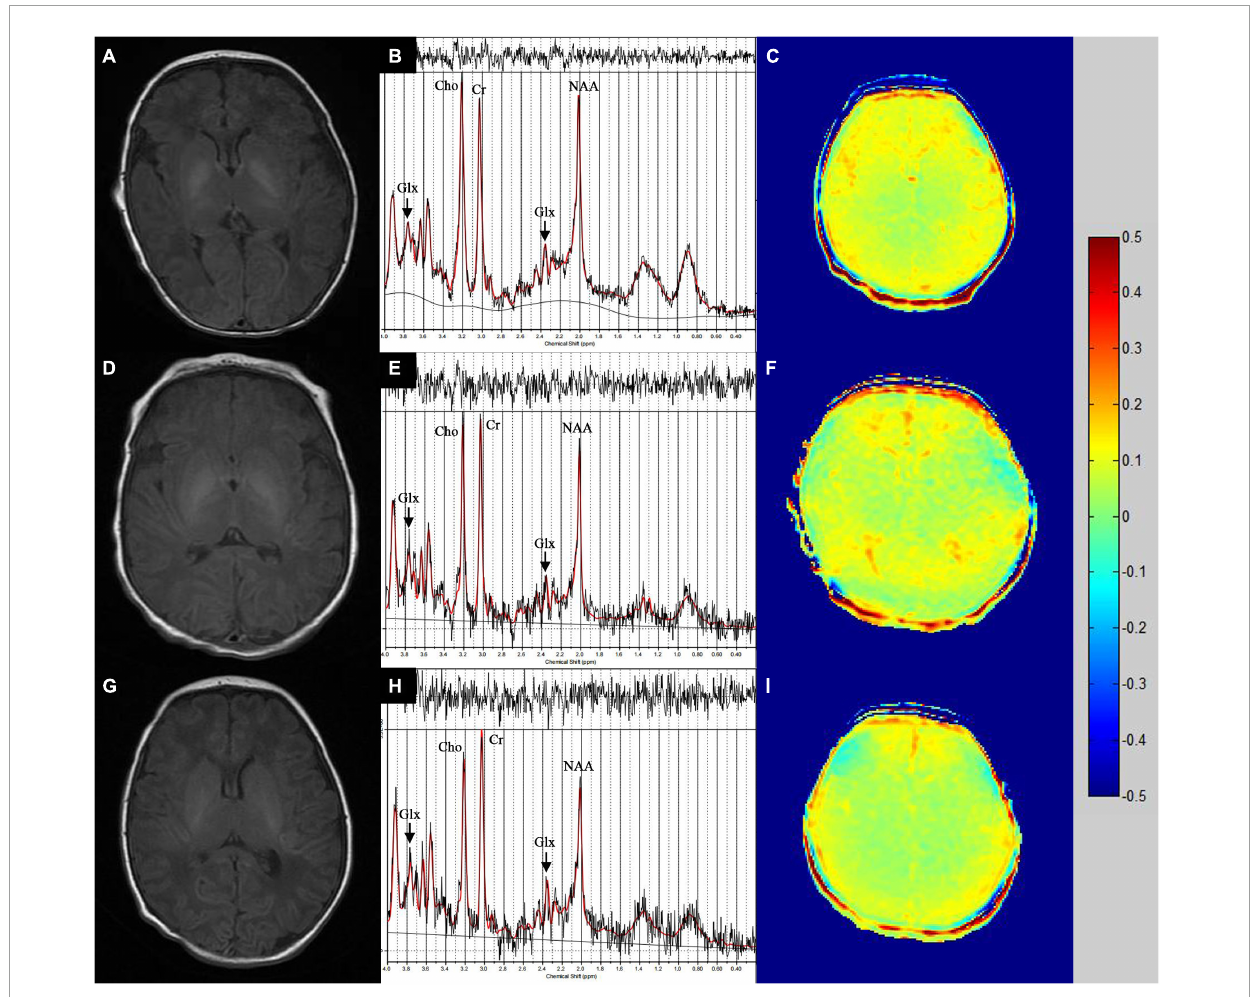
FIGURE2 (A) A case with acute moderate and severe bilirubin encephalopathy (BIND score = 7) and (D) a case with acute mild bilirubin encephalopathy (BIND score = 3) manifested hyperintensity on T1WI in bilateral basal ganglia. The positive rate of bilateral basal ganglia T1WI hyperintensity increased along with rising disease severity. (G) No aberrant signal was observed in the bilateral basal ganglia of the healthy neonates. (B,E,H) 1 H-MRS images of right basal ganglia in the moderate and severe subgroup, the mild subgroup and the control group. (C,F,I) Glu-CEST image post-processing in the moderate and severe subgroup, the mild subgroup and the control